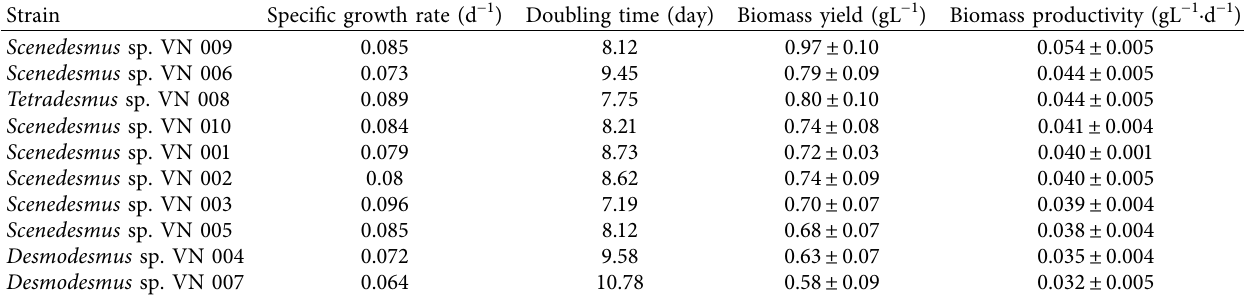
Table 3: Top ten biomass productivity values of the isolated microalgae.